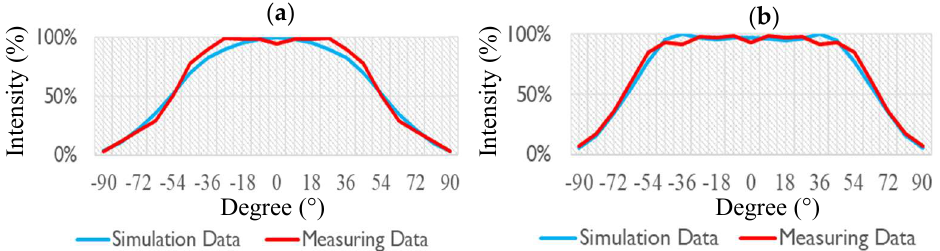
Figure 16. Light distribution curves of the light guide layer unit module combined with diffusion film (simulation optimization and measurement results): ( a ) without concave PSMLAs; ( b ) with concave PSMLAs.